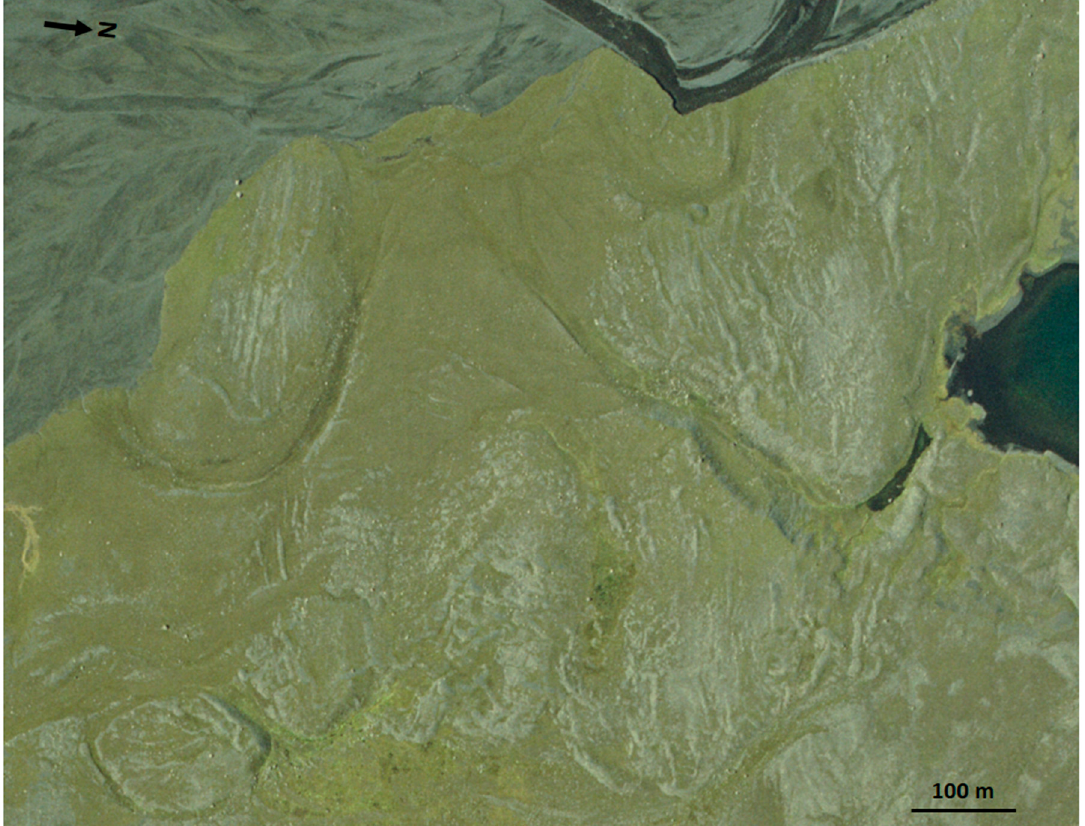
Figure 10. Aerial photograph extract (NERC ARSF 2007) of an area within the fluted till surface on the inner foreland of Sandfellsjökull that includes abundant geometric ridge networks (crevasse squeeze ridges) and sinuous, ice flow-parallel till ridges (till eskers; see Evans et al.,